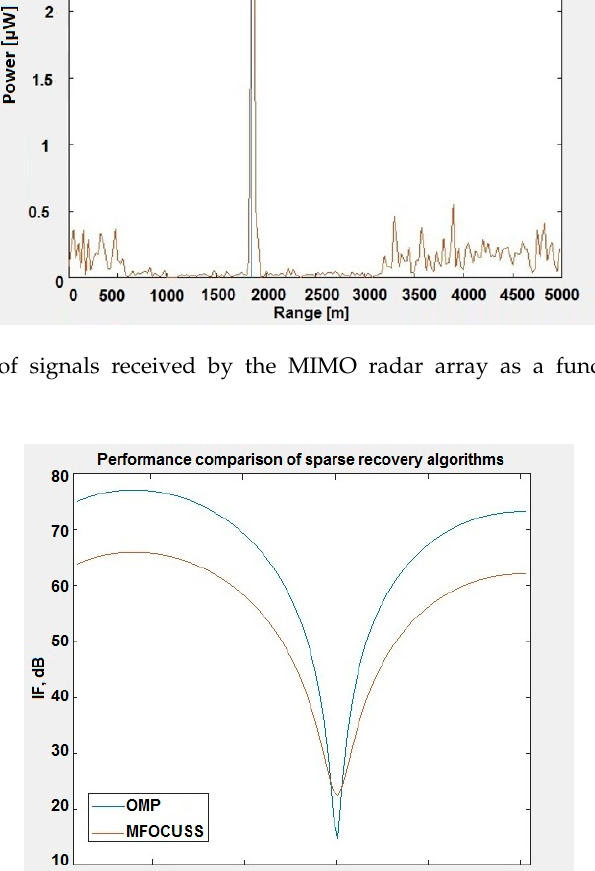
Figure 7. Performance comparison of sparse recovery algorithms.